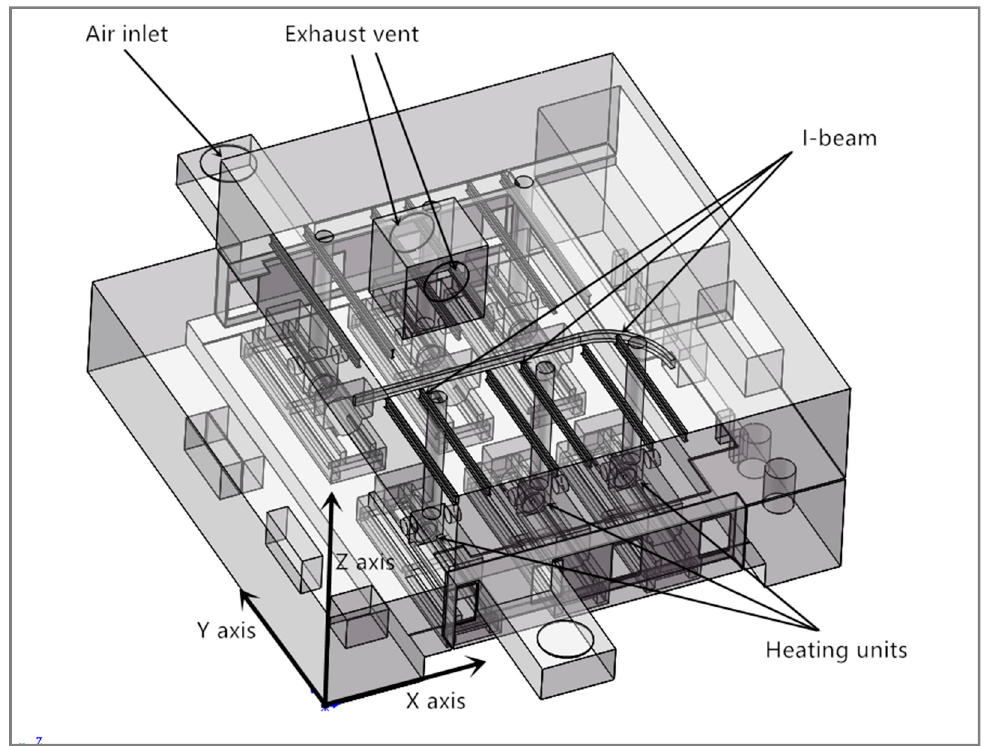
Figure 1. Three-dimensional model of the main cabin of the offshore platform.